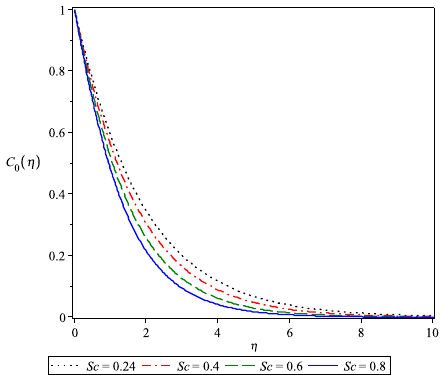
Figure 5. Dependency of concentration profile C 0 on the Schmidt number Sc when N = 0.8 and K = 0.2.